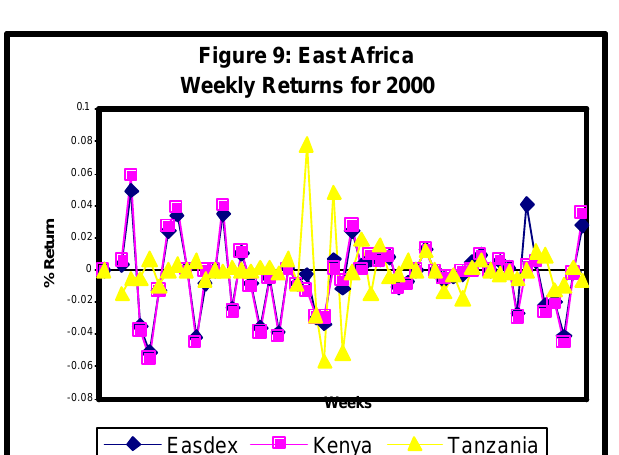
Figure 10: North Africa NADEX vs constituent